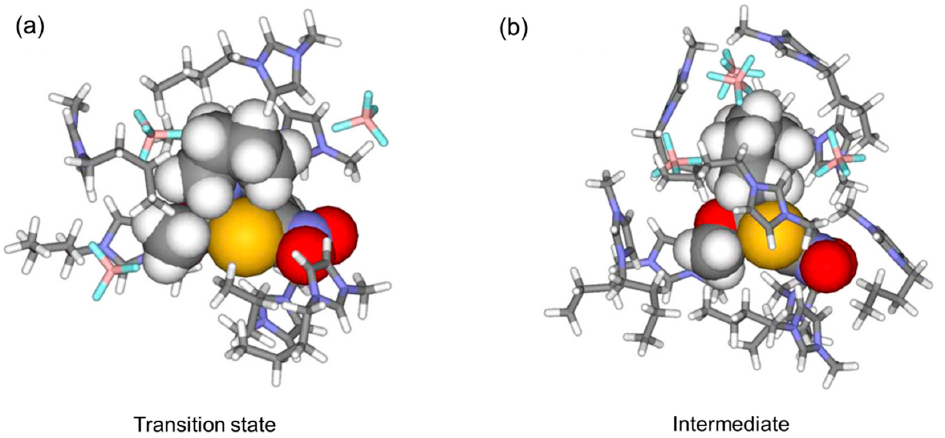
Figure 8. First-solvation shell [Bmim][BF 4 ] encapsulation of the ( a ) addition transition state and ( b ) the Meisenheimer intermediate, for the S N Ar reaction between piperidine and 2-methoxy-5- nitrothiophene. Ref.